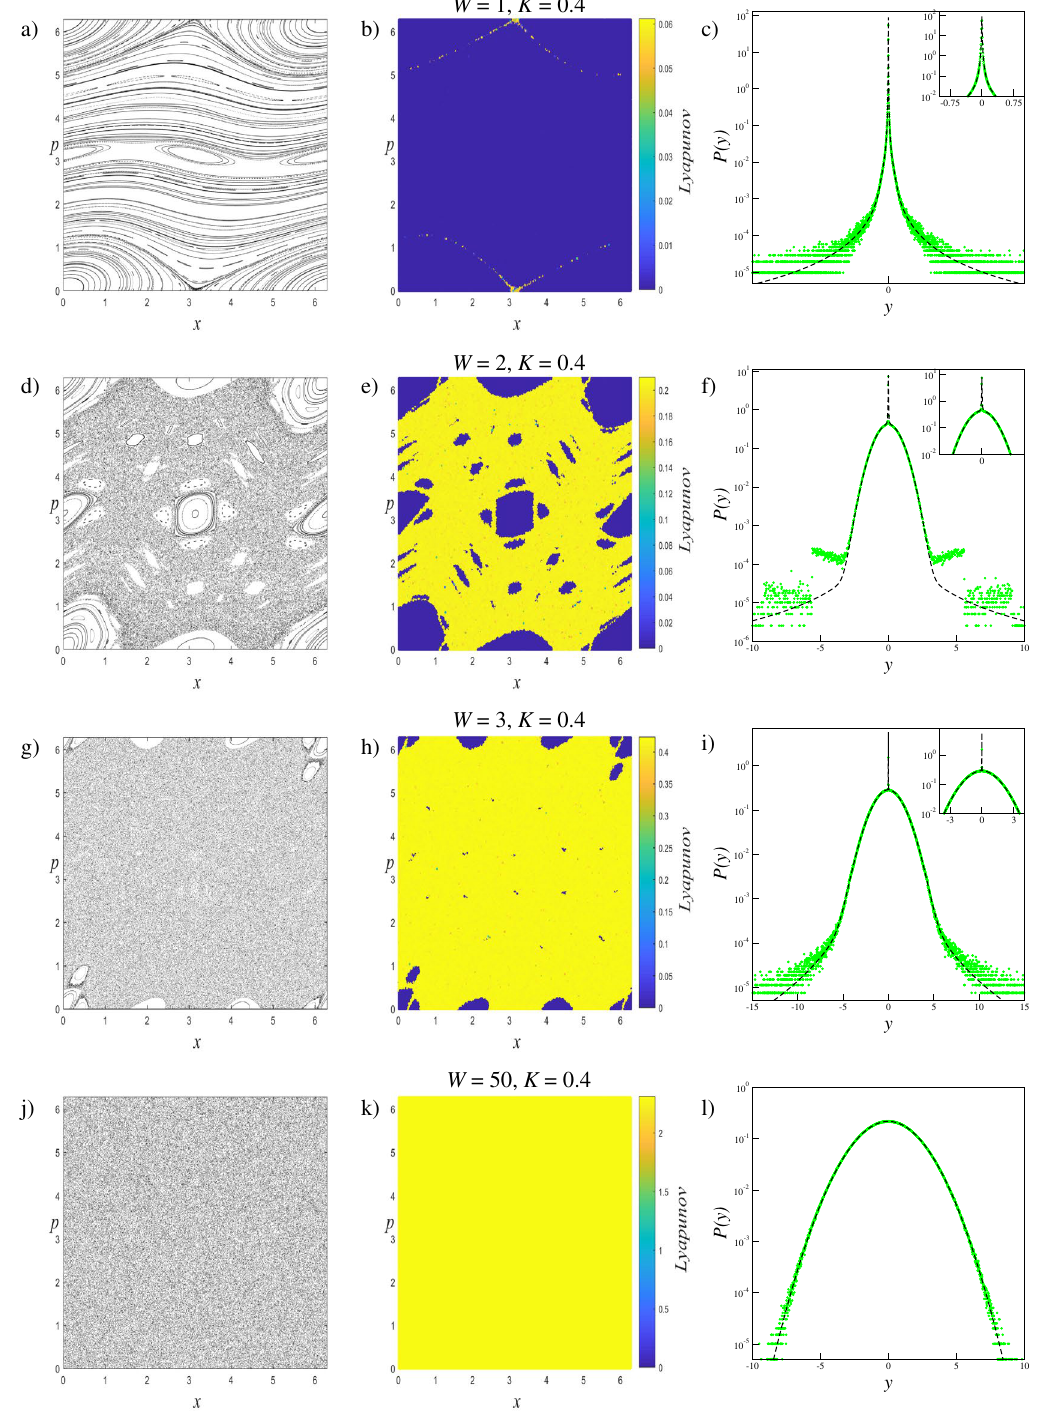
Figure 4. Analyses of the W = 1 , W = 2 , W = 3 , and W = 50 systems for K = 0.4 . Left column: ( a , d , g , j ) Phase space portraits, Middle column: ( b , e , h , k ) LLE color map descriptions of the phase portraits, Right column: ( c , f , i , l ) Probability distributions obtained from the initial conditions chosen from the entire phase